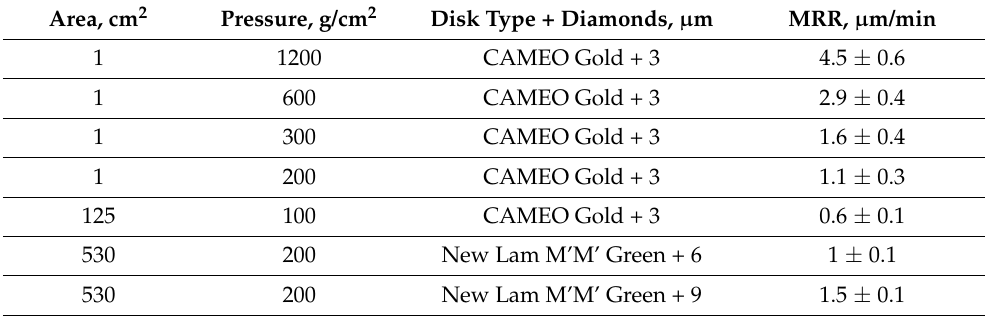
Figure 19. Photographs of the tested lapping disks ( a , c , e ) and surface quality of niobium disks after Step 1 ( b , d , f ). Table 3. Material removal rate for different polishing configurations.